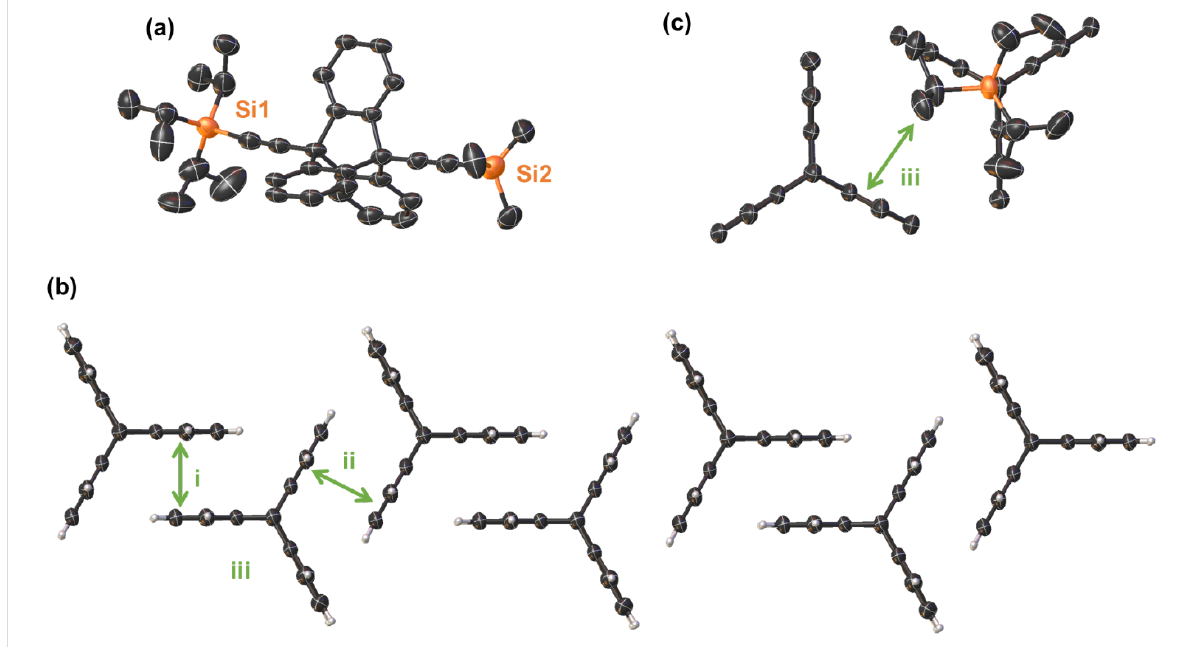
Figure 2: Single crystal X-ray structure of triptycene 5 . (a) Molecular structure of 5 in the crystal with hydrogen atoms and minor disorder omitted for clarity (thermal displacement 50%); (b) expanded view showing the π -stacking between the i and ii rings (thermal displacement 50%). Bridgehead substituents have been omitted for clarity; (c) expanded view showing C–H··· π interactions between the TIPS group of one molecule and the third pocket (iii) of another triptycene molecule. Hydrogen atoms and minor disorder omitted for clarity (thermal displacement